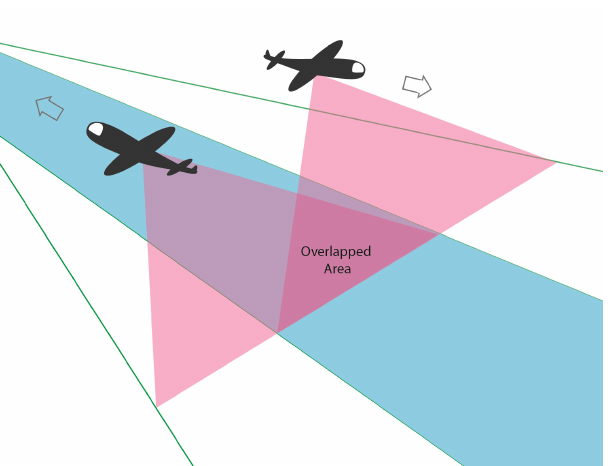
Figure 1. Overlapping LiDAR data